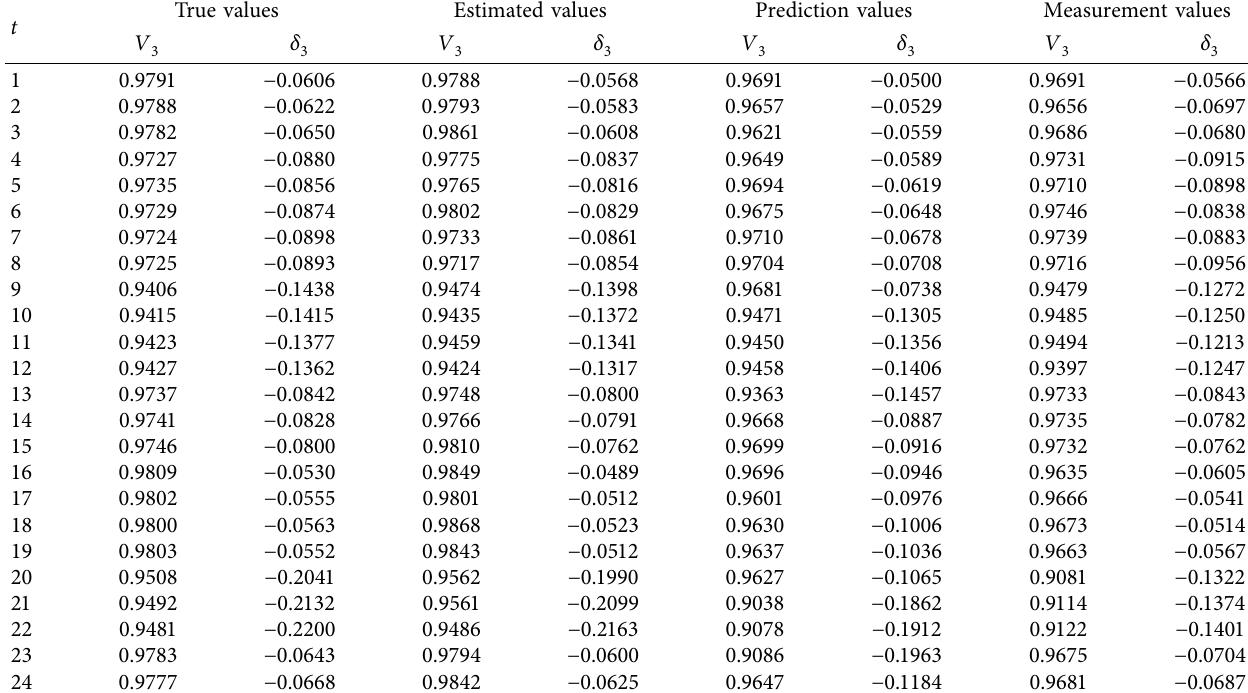
Table 8: Comparison of measured, predicted, estimated, and true values for the voltage phasor of busbar 3 in the 3-bus network. True values Estimated values Prediction values Measurement values t